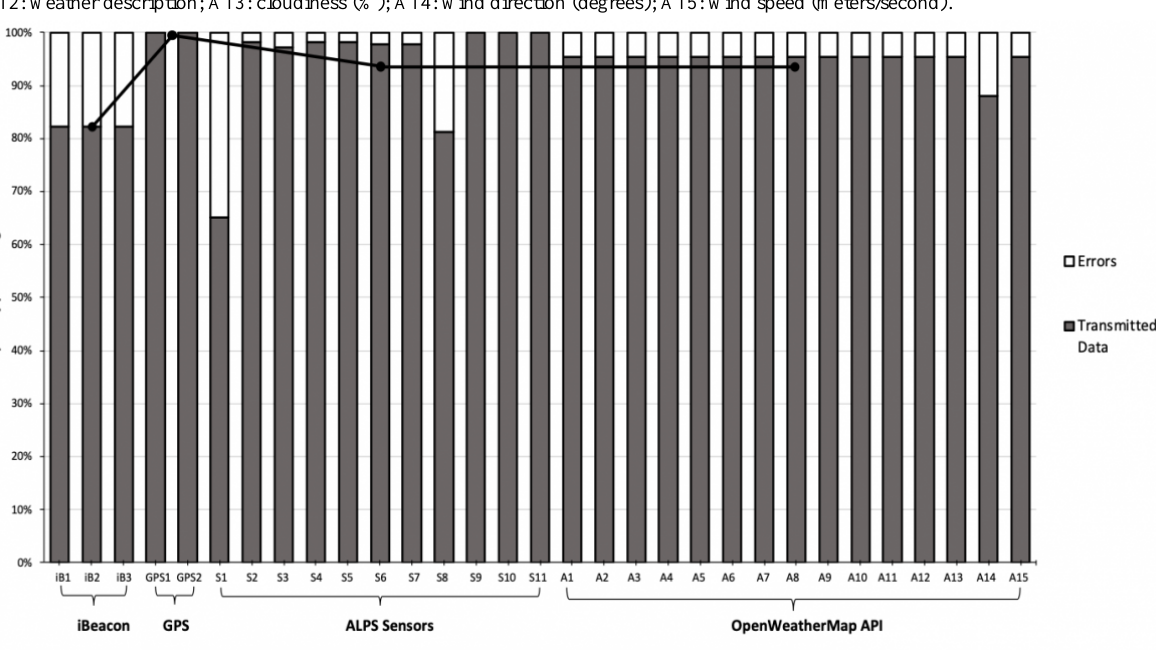
Figure 6. Frequency percentages of transmitted data and errors in each data type, and mean scores (black dots) in each data source detected and transmitted by the ChildSIDE app to the database. iB1: MAC address; iB2: radio signal strength indication; iB3: iBeacon name; GPS1: longitude; GPS2: latitude; S1: ultraviolet (UV) range (mW/cm2); S2, S3, S4: 6-axis (Accel+Geomag) sensor ranges [g]; S5, S6, S7: 6-axis (Accel+Geomag) sensor resolutions [μT]; S8: UV resolution [Lx]; S9: pressure sensor range (hPa); S10: temperature and humidity sensor range ( ℃ ); S11: temperature